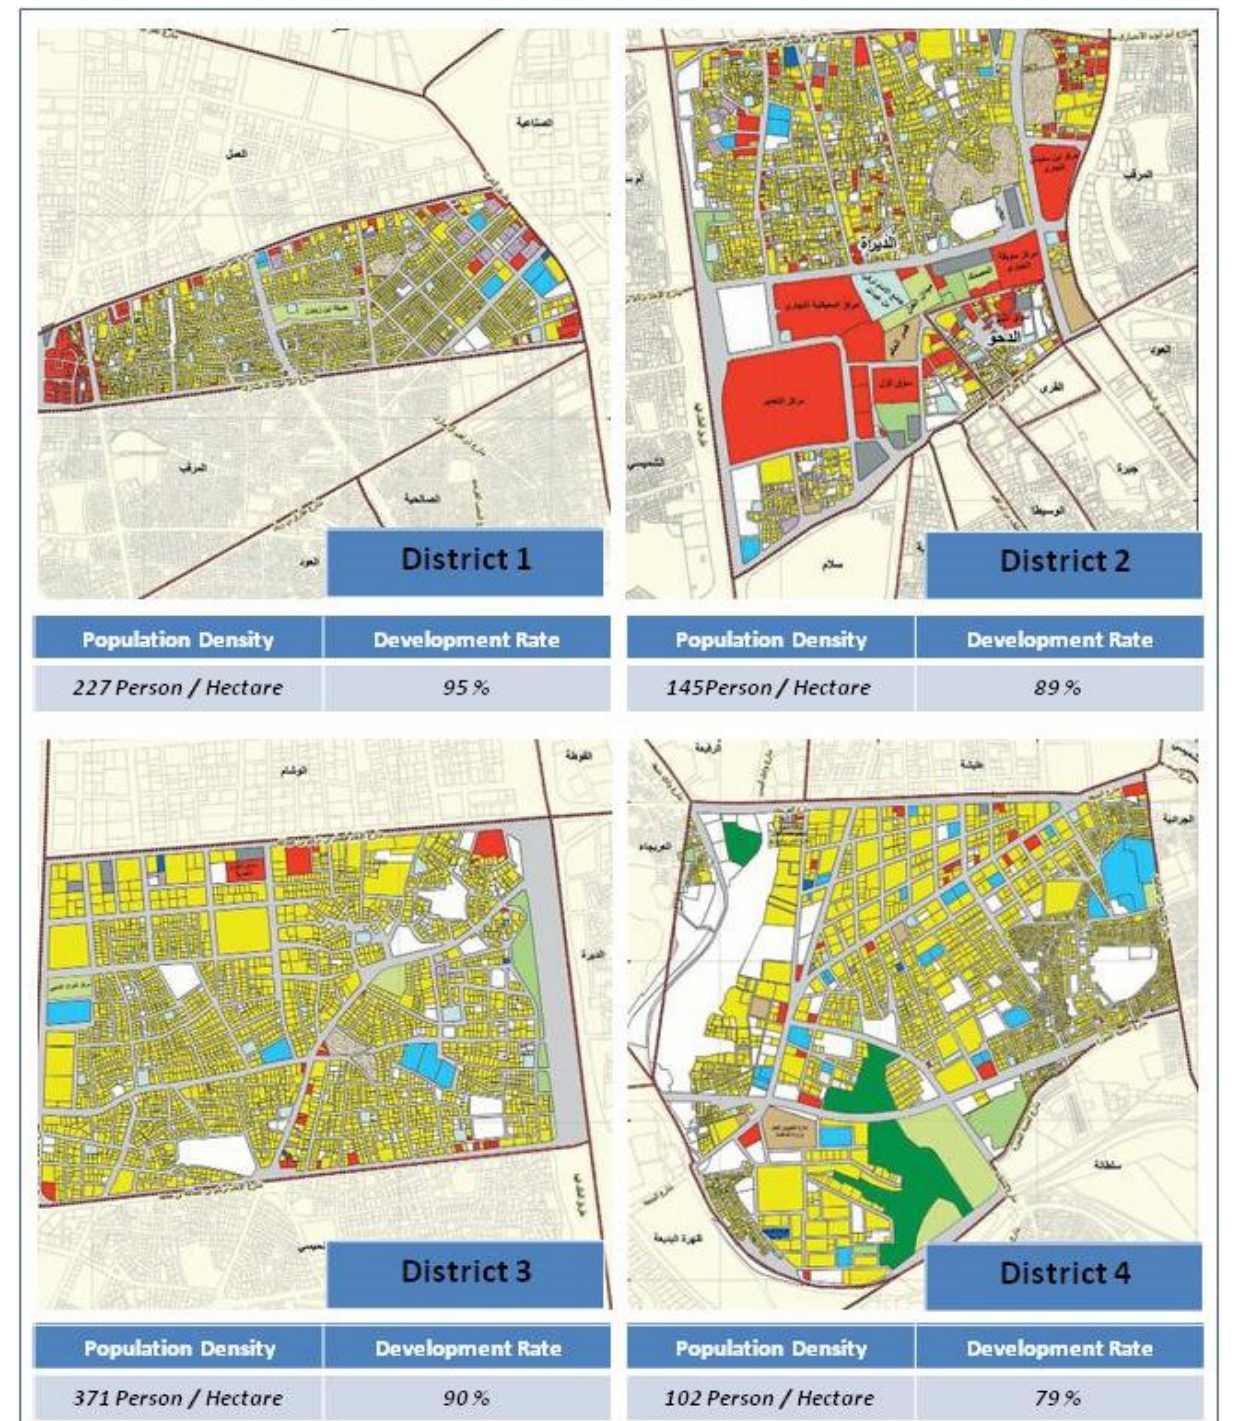
Figure 8. Detailed land use of some areas in the historical centre (ADA,